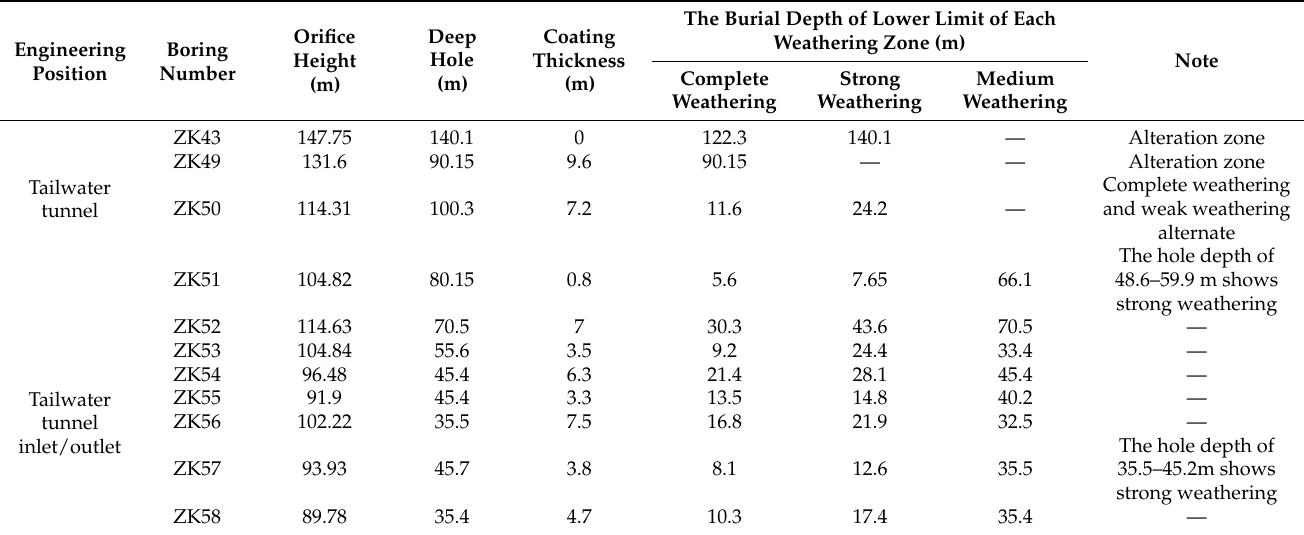
Table 1. Summary statistics of the weathered depths of the drilled holes in the tailwater